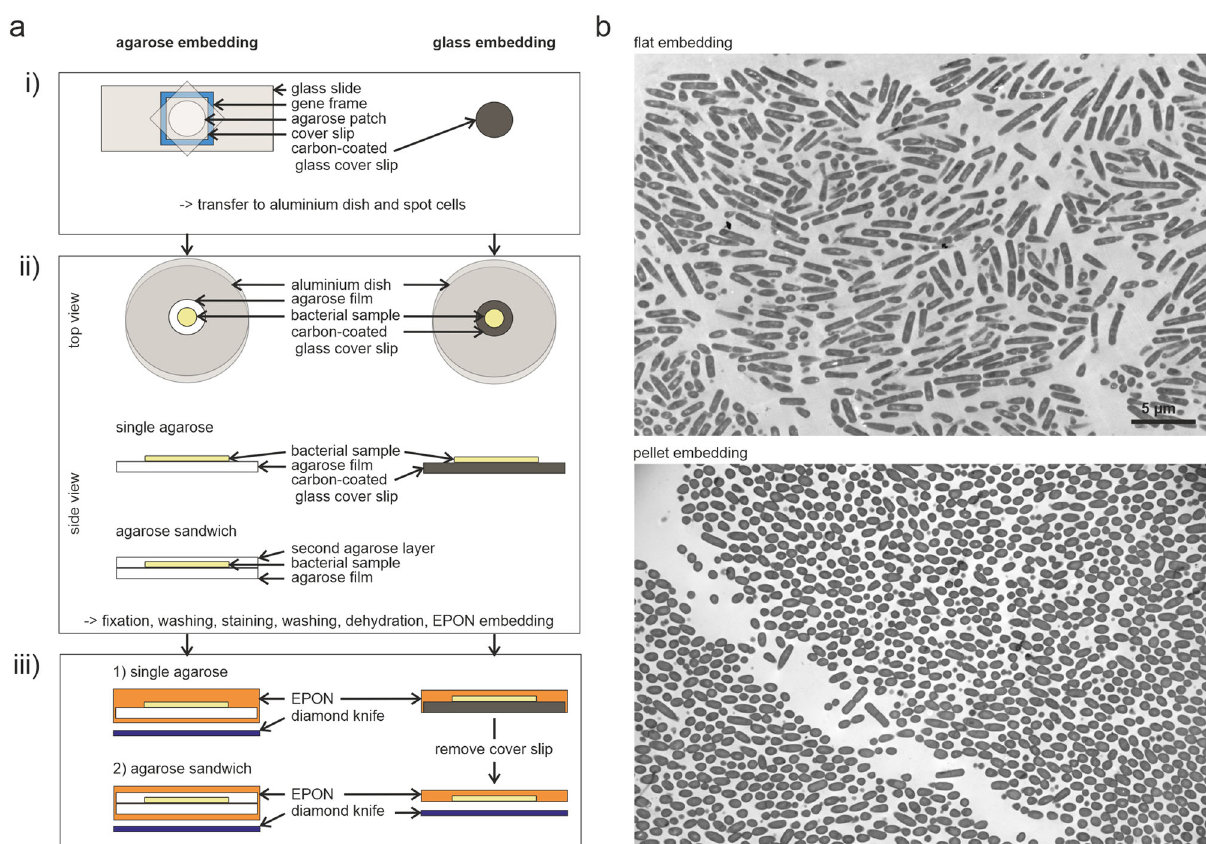
Fig. 1 The fl at embedding technique. a Schematic representation of the fl at embedding work fl ow including embedding on a single layer of agarose, embedding in an agarose sandwich (used here for mycobacteria), and embedding on carbon-coated glass coverslips. (i) Preparation of the surface. Uniform thickness of the agarose fi lm is ensured by using a gene frame as spacer. (ii) The agarose or glass surface is transferred to an aluminum dish and a small drop of cell sample is spotted on top of the surface and allowed to evaporate under a slight air fl ow. For the agarose sandwich approach, a second fl at layer of agarose is added on top of the cells without using a gene frame. (iii) Samples after EPON embedding. For glass embedding, the glass coverslip is broken off the EPON disc prior to sectioning. b Overview pictures of B. subtilis 168 cells embedded on a single agarose layer (top) and as pellet (bottom) at 5000x magni fi